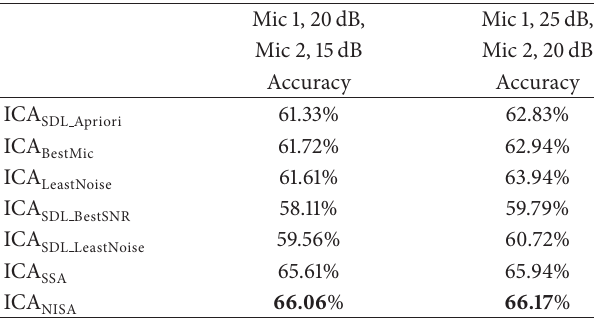
Table 2: Classification accuracy of seven ICA-based methods for source separation for data comprising clean sounds of daily life data in which noise was artificially mixed, to ensure that noise components were perfectly correlated between